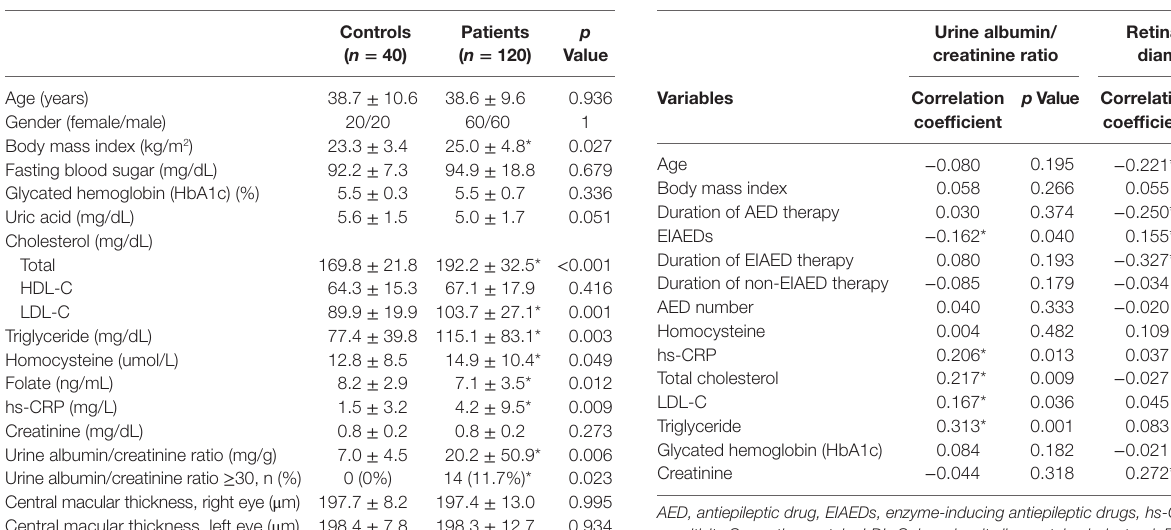
TaBle 2 | Demographic data and vascular risk factors in patients with epilepsy vs.